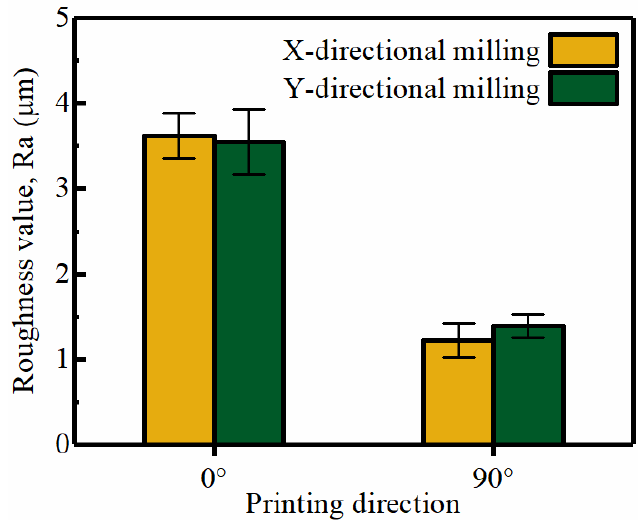
Figure 6. Comparison of surface roughness values of milled specimens.